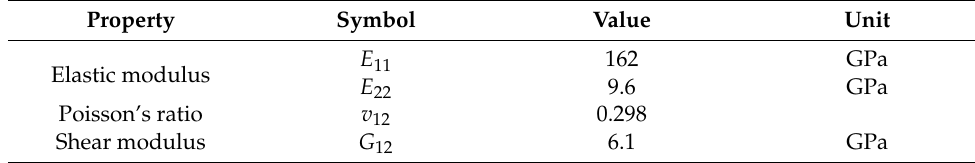
Table 2. Mechanical properties.